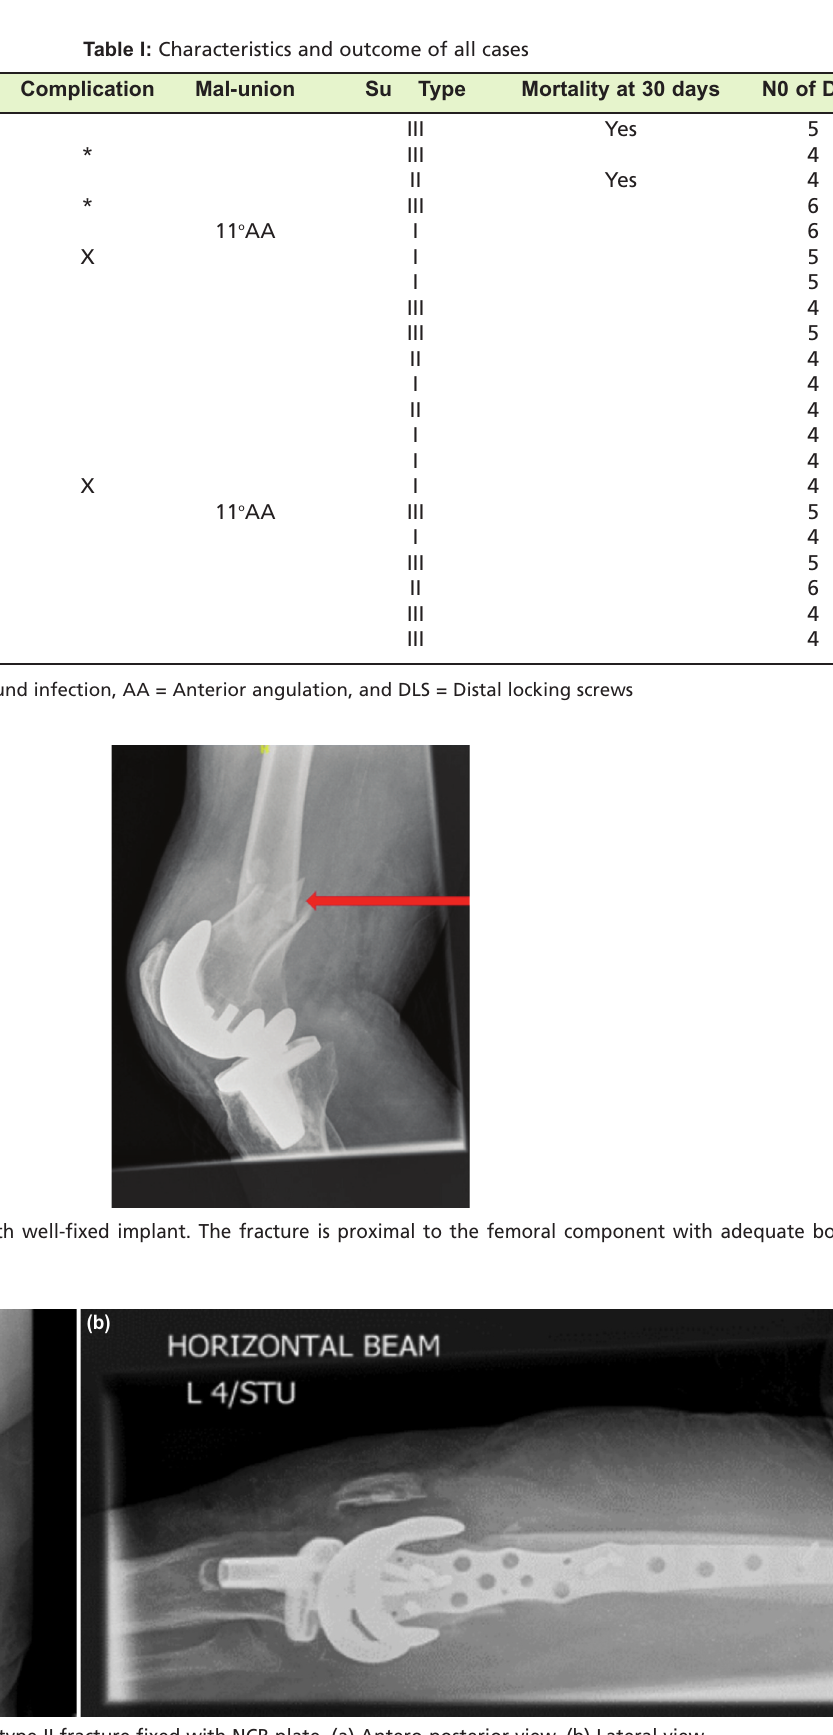
Post-operative Su type II fracture fixed with NCB plate. (a) Antero-posterior view. (b) Lateral Fig. 2: